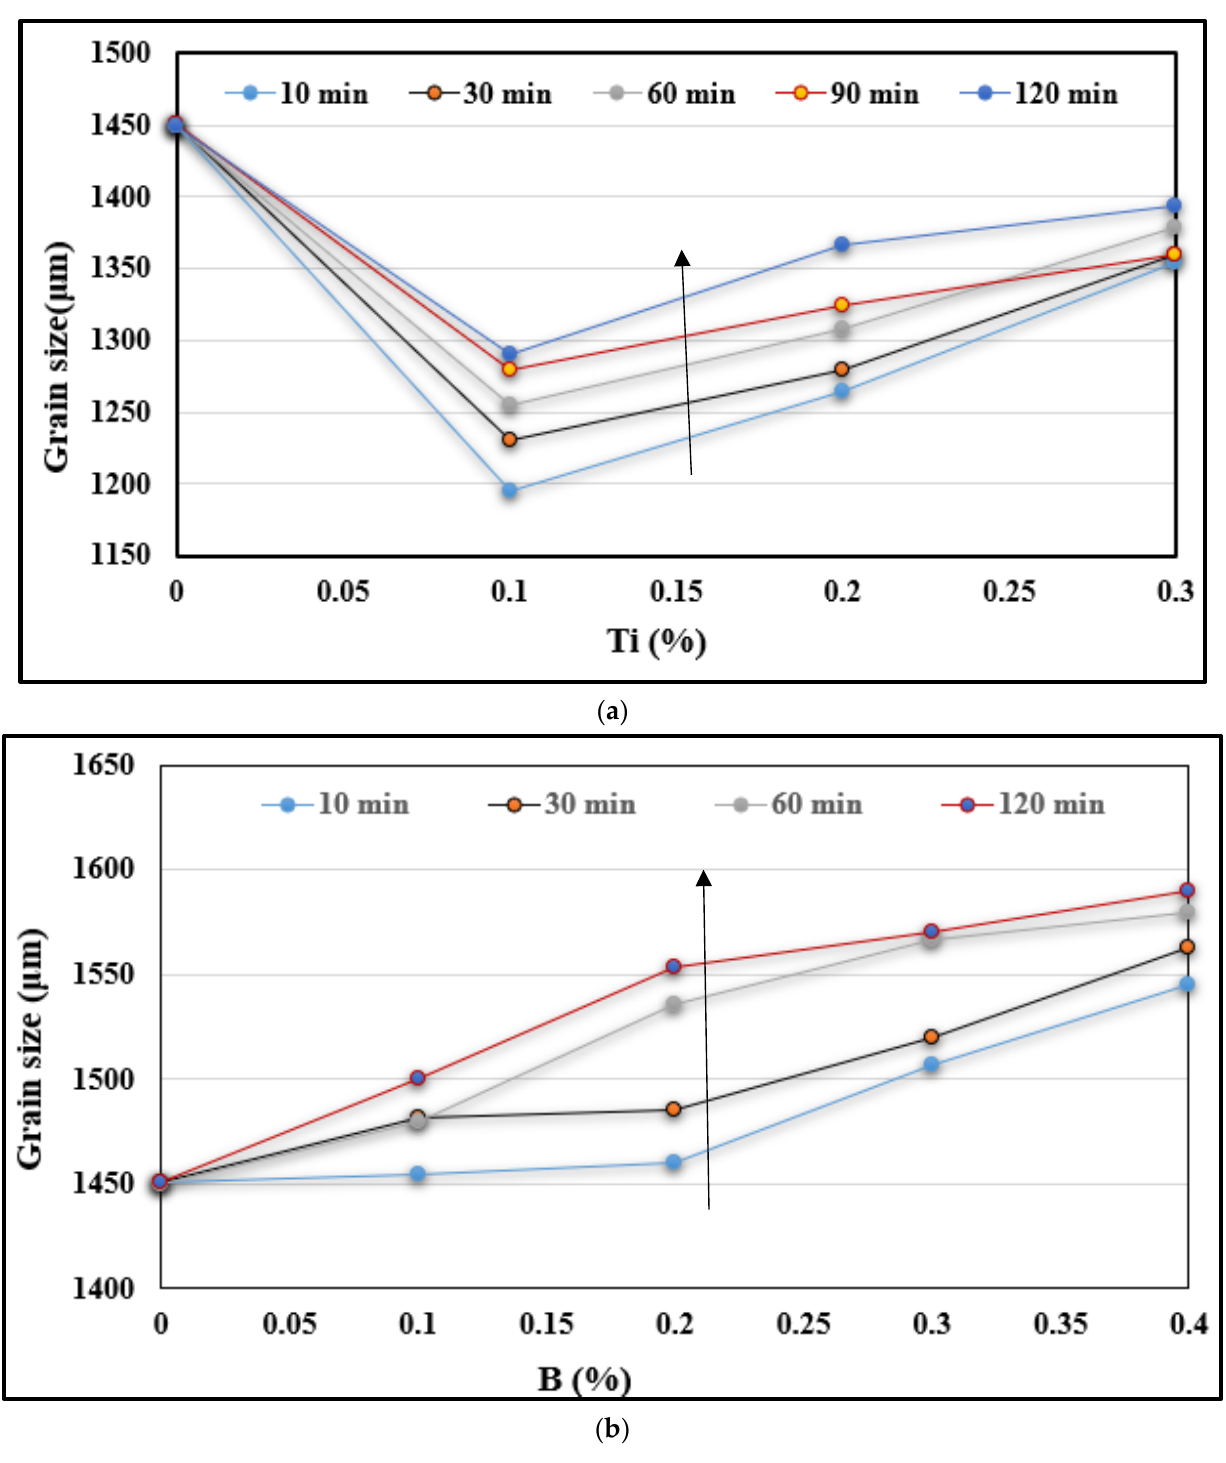
Figure 18. Effect of ( a ) Ti and ( b ) B addition on the grain size of the A390 alloy. Note the increase in the grain size with the increase in holding time, as noted by the vertical black arrows in each case.